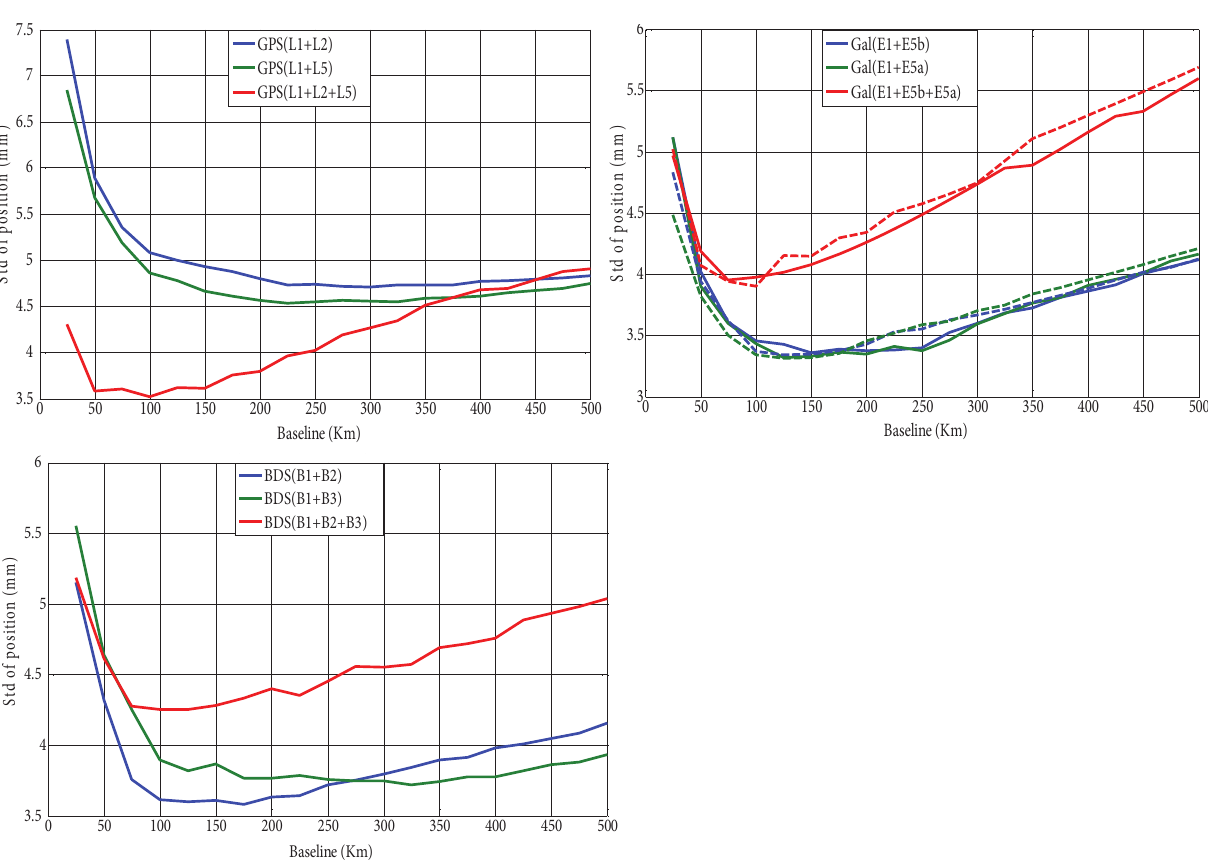
Figure 2. Variation of standard deviations of fixed coordinates with baseline length for GPS (Top), Galileo (Medium) and BDS (Bottom). Solid line means spatial correlation accounted and dashed line without spatial correlation. 5 s interval, success rate: 99.9 % and 10 satellites continuously tracked for each